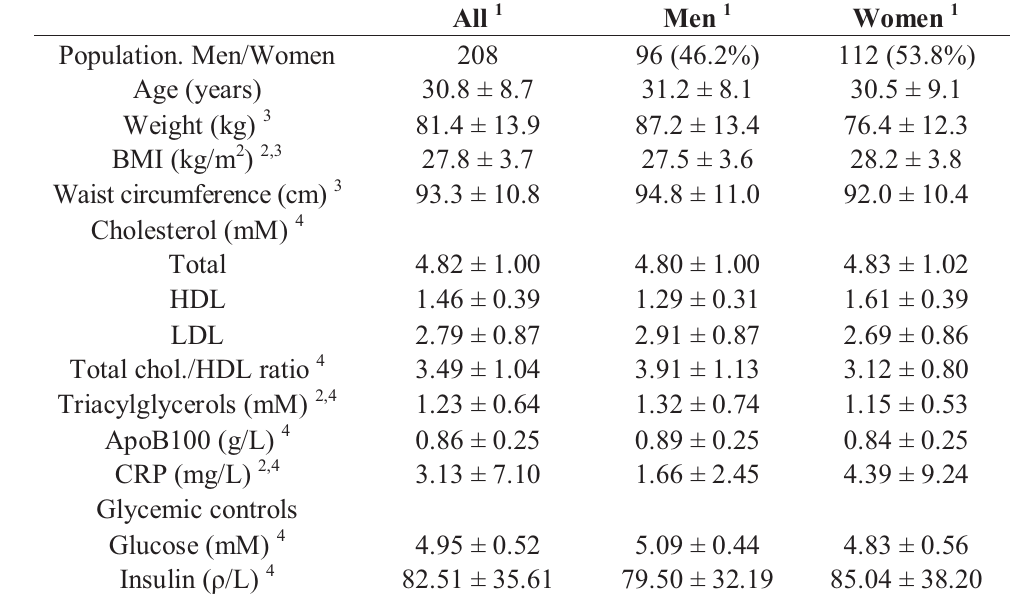
Table 1. Baseline characteristics of the study sample before n-3 polyunsaturated fatty acids (PUFA)